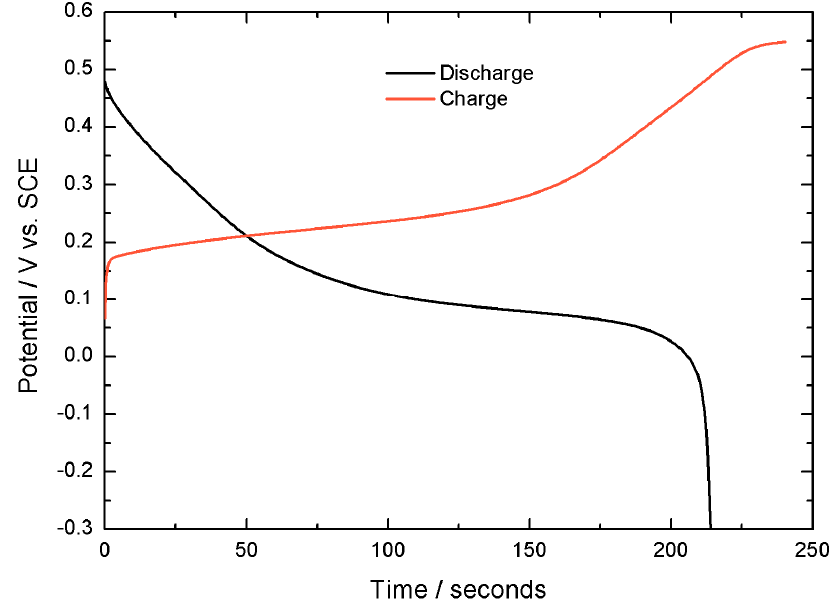
Figure 3. Galvanostatic charge and discharge curves obtained at 10 mA cm − 2 for the positive electrode, nickel-cobalt hydroxide.